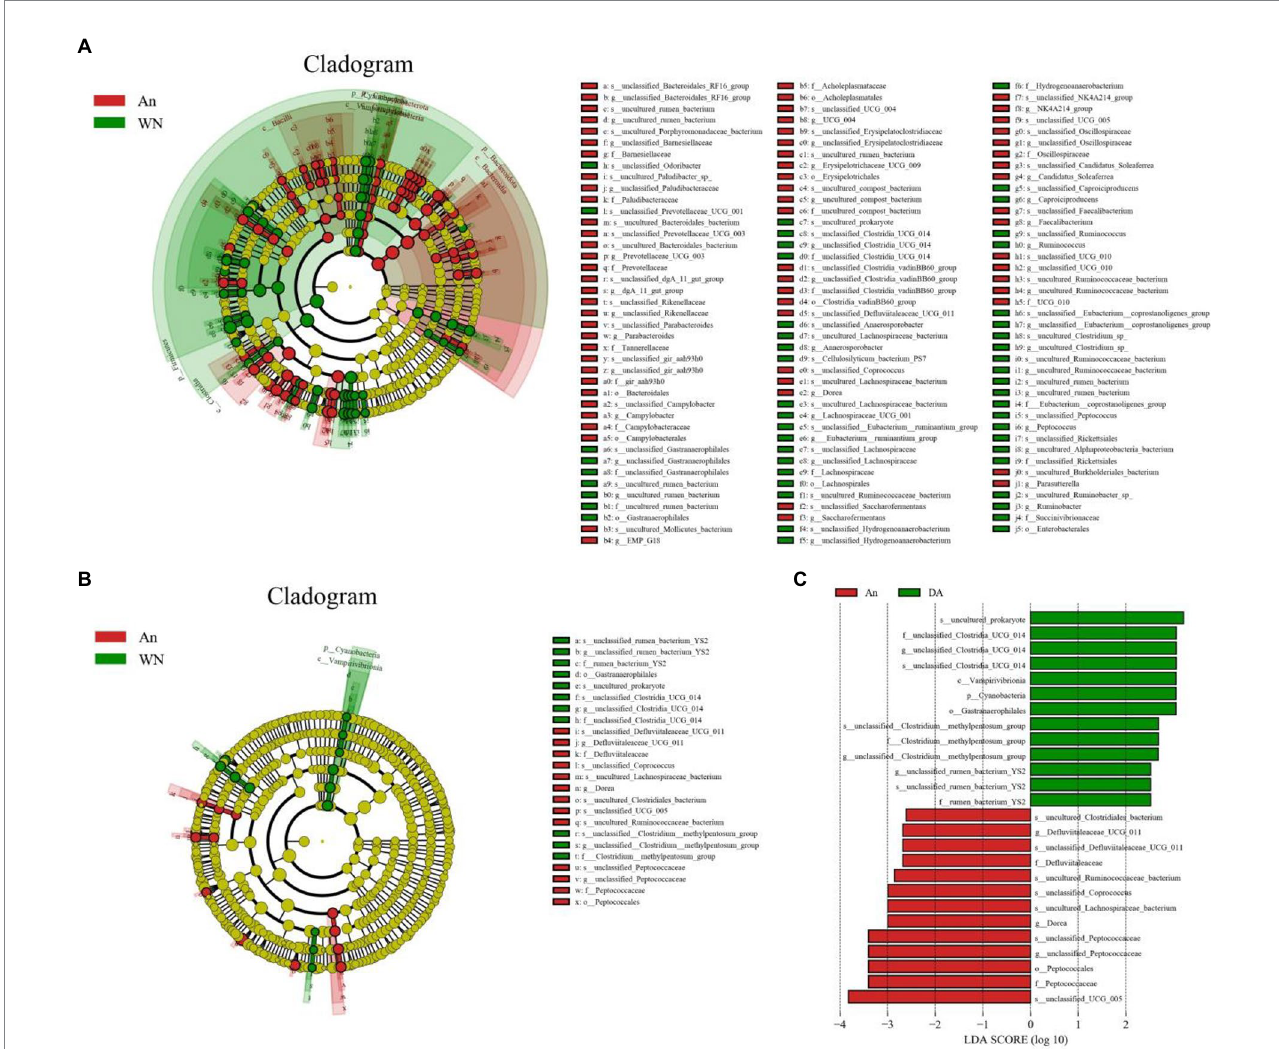
FIGURE 6 LEfSe integrated with LDA scores recognized differentially abundant taxon related to species and diarrhea. (A,B) Cladogram shows the phylogenetic distribution of differential taxon. (C) LDA scores >2 are considered